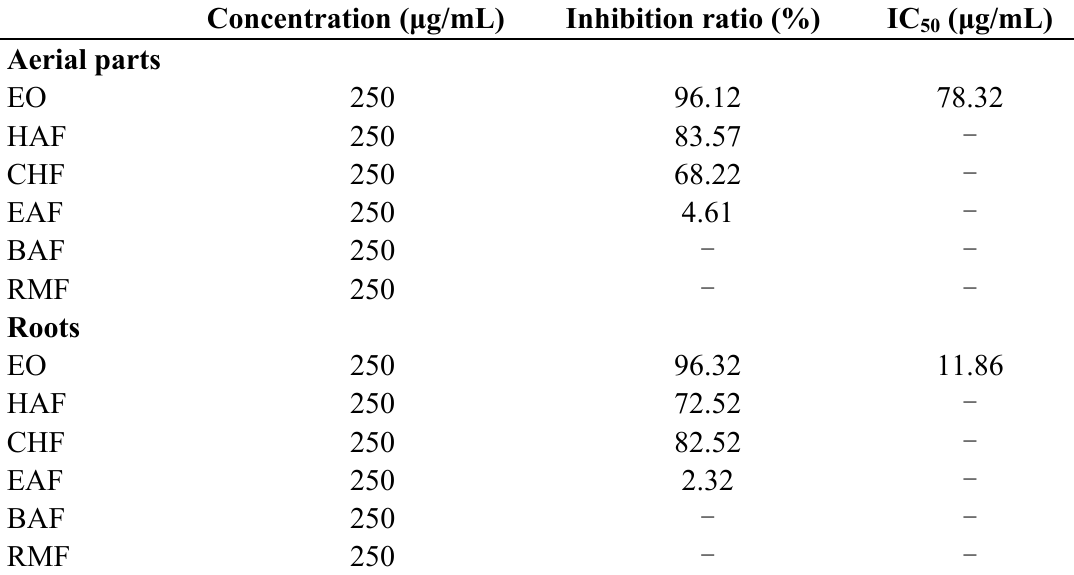
Table 2. Antitumor activity of essential oils and crude extracts of aerial parts and roots of E. macrorrhiza for Caco-2